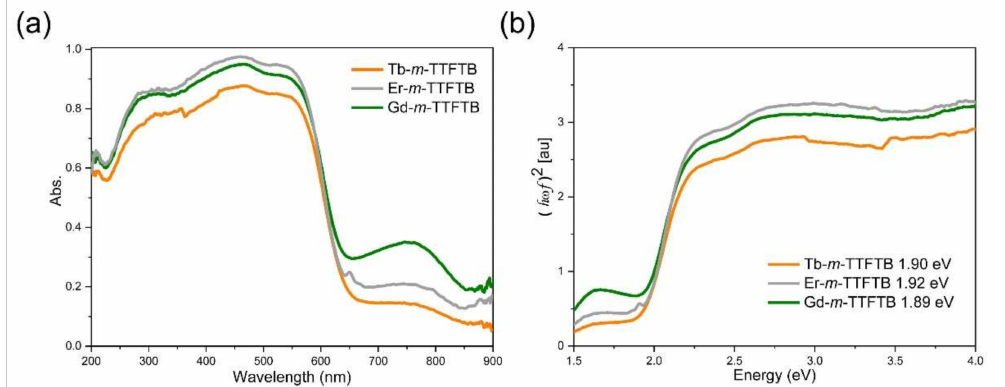
Figure 4. The diffuse reflectance spectra ( a ) and the translated Tauc plots ( b ) for Tb- m -TTFTB, Er- m -TTFTB, and Gd- m